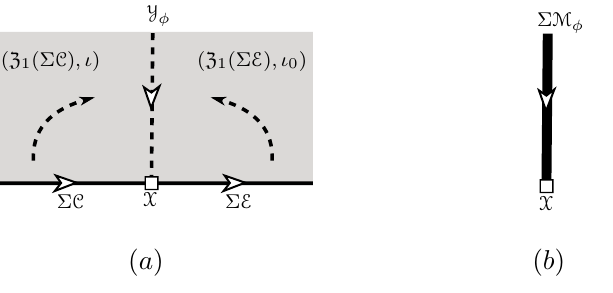
Figure 5 . Picture (a) depicts a physical con(cid:12)guration that illustrates the relation among (cid:6) E ; (cid:6) C . Y (cid:30) denotes the 2d invertible domain wall between two 3d bulks associated to the braiding equivalence (cid:30) : Z 1 ((cid:6) E ) ! Z 1 ((cid:6) C ) and (cid:19) ’ (cid:30) (cid:14) (cid:19) 0 . Picture (b) depicts the result of the closing-fan process indicated by the dotted lines in Picture (a) (see